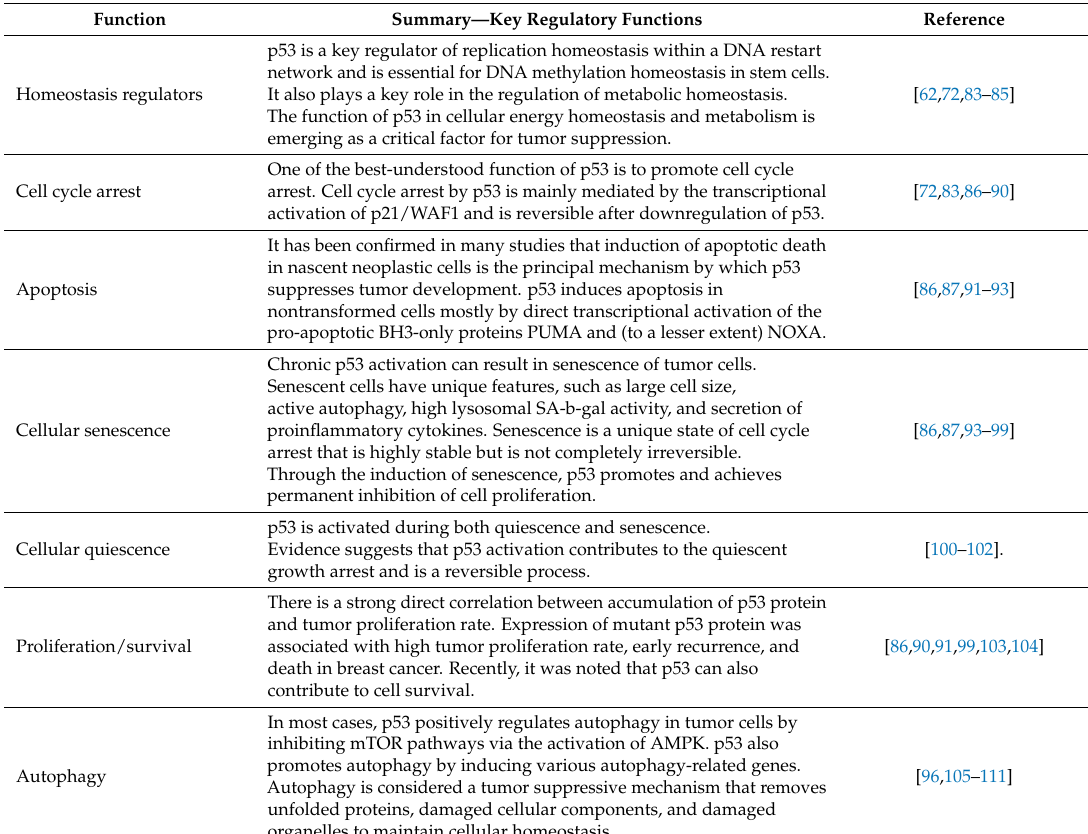
Table 1. Known functions of wild-type